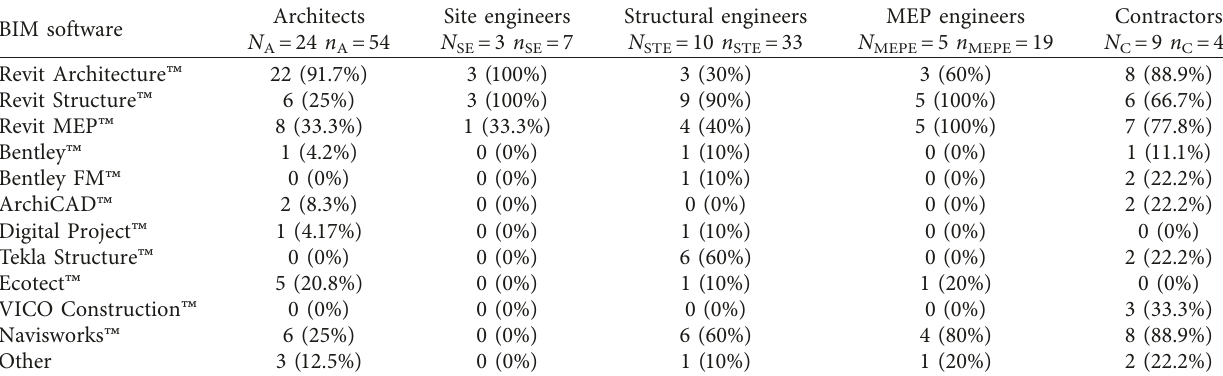
Table 8: Relationship between respondent’s role and the BIM software they use in projects ∗ .